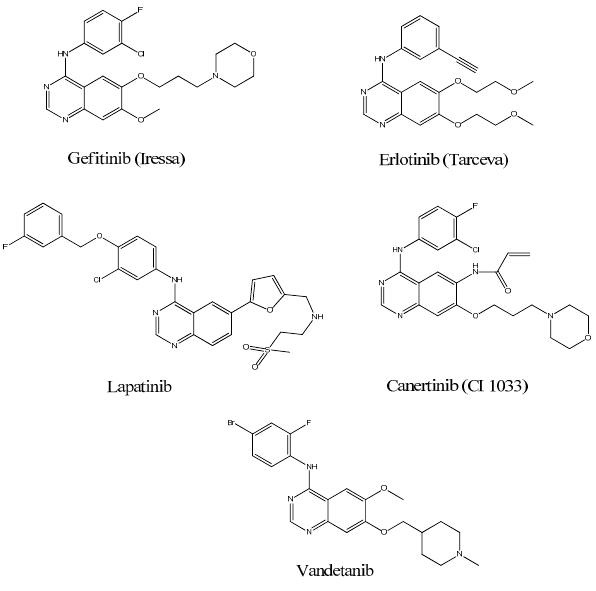
Figure 1. EGFR-tyrosine kinase inhibitors.